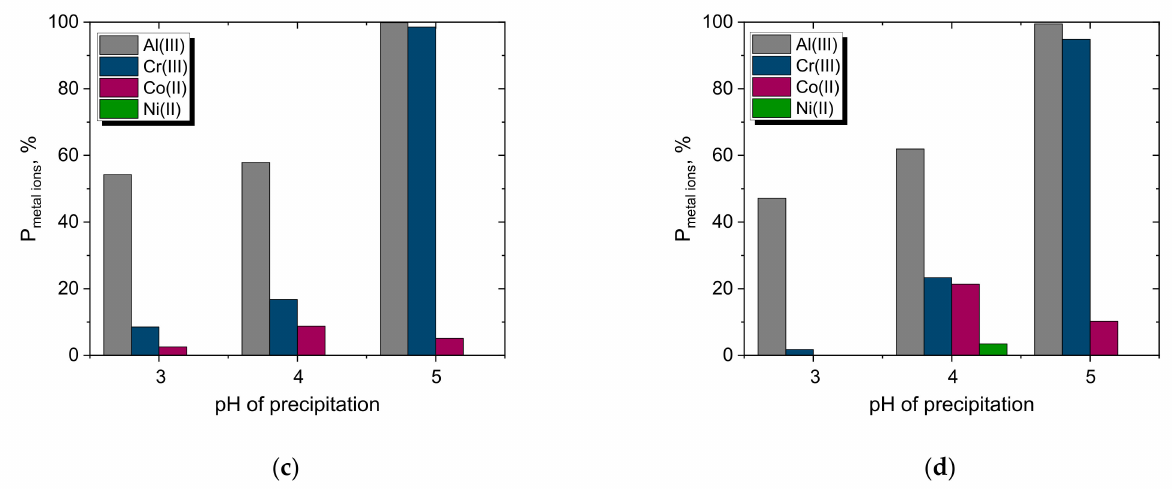
Figure 9. Yield of precipitation of Cr(III), Ni(II), Co(II) and Al(III) with solutions of ( a ) NaOH, ( b ) CaO, ( c ) NaHCO 3 , ( d ) Na 2 CO 3 from the real PLS at the assumed pH values 3, 4 or